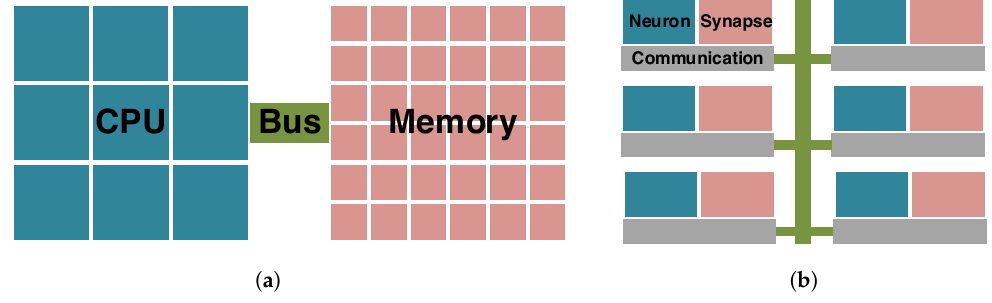
Figure 2. Block diagram of computing systems: ( a ) von Neumann architecture; ( b ) neuromorphic